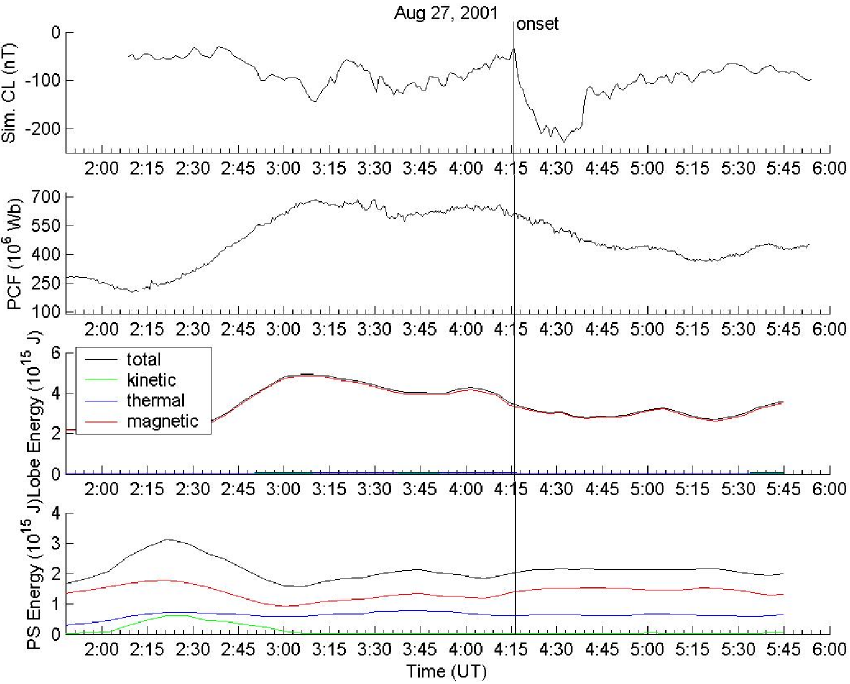
Fig. 9. Panel 1 shows the simulated CL index, panel 2 shows the polar cap flux. The evolution of total (black), kinetic (green), thermal (blue), and magnetic (red) energies in lobe and plasma sheet is seen in panels 3 and 4, respectively.